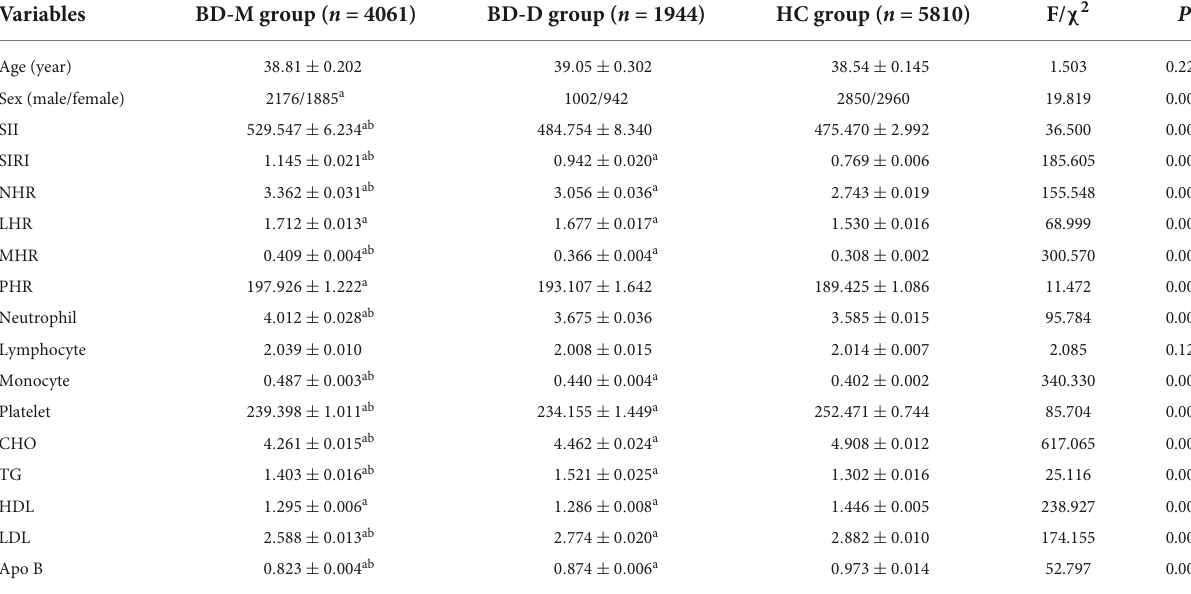
TABLE 2 Comparison of demographic features and laboratory indicators between BD manic episodes (BD-M), BD depressive episodes (BD-D), and healthy controls (HCs).